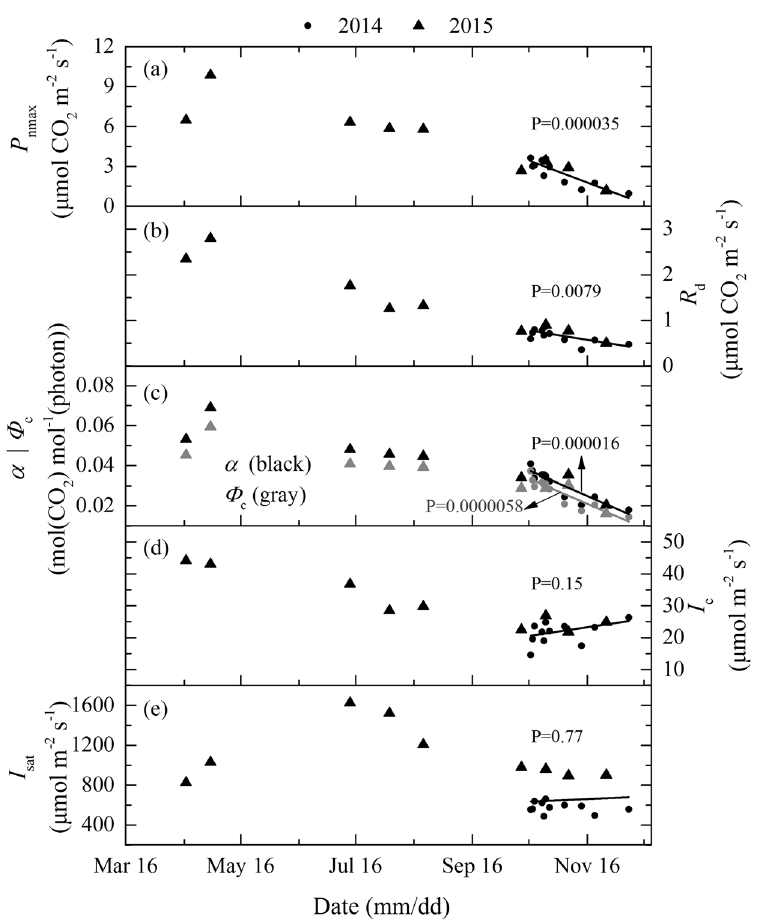
Figure 3. The model simulated maximum net photosynthetic rates ( P nmax ), dark respiration rates ( R d ), light compensation point ( I c ), light saturation point ( I sat ), apparent quantum yield ( α ) and the quantum yield at I c ( Ф c ) of L . formosana in 2014 and 2015. Lines represent linear trend during leaf senescence, a P value smaller than 0.05 means the slope is significantly different from zero. Each data point is simulated from daily light response data composed of measurements on at least 27